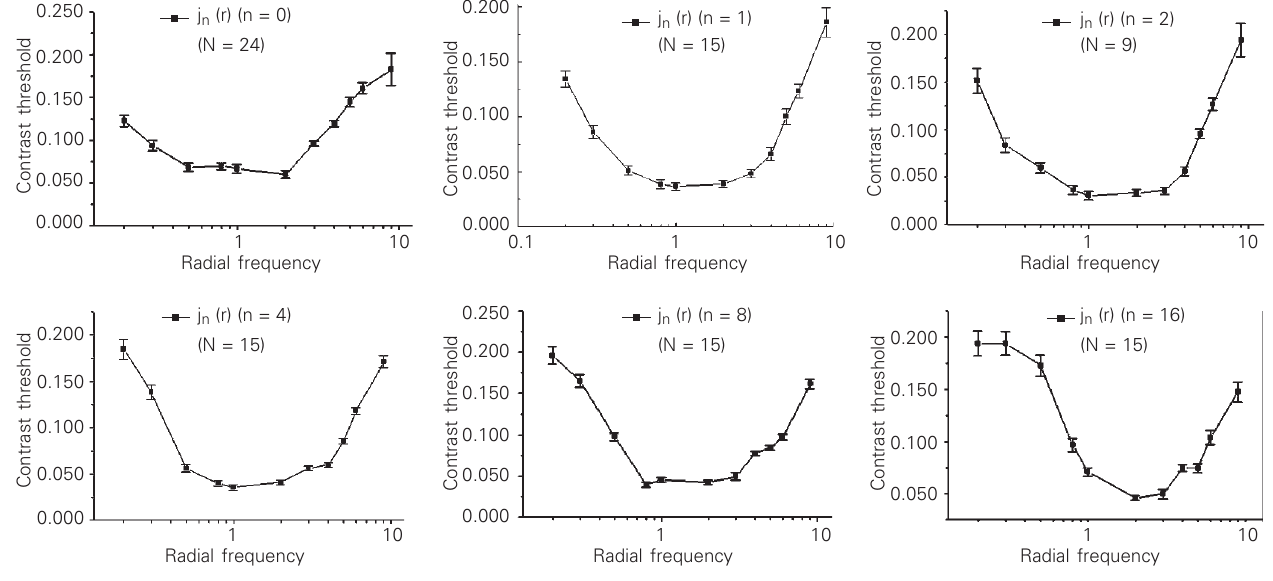
Figure 7. Contrast thresholds for radial frequencies modulated by j n (r) Bessel profiles of n-orders 0 (zero), 1, 2, 4, 8 and 16. N represents the number of measured functions for all